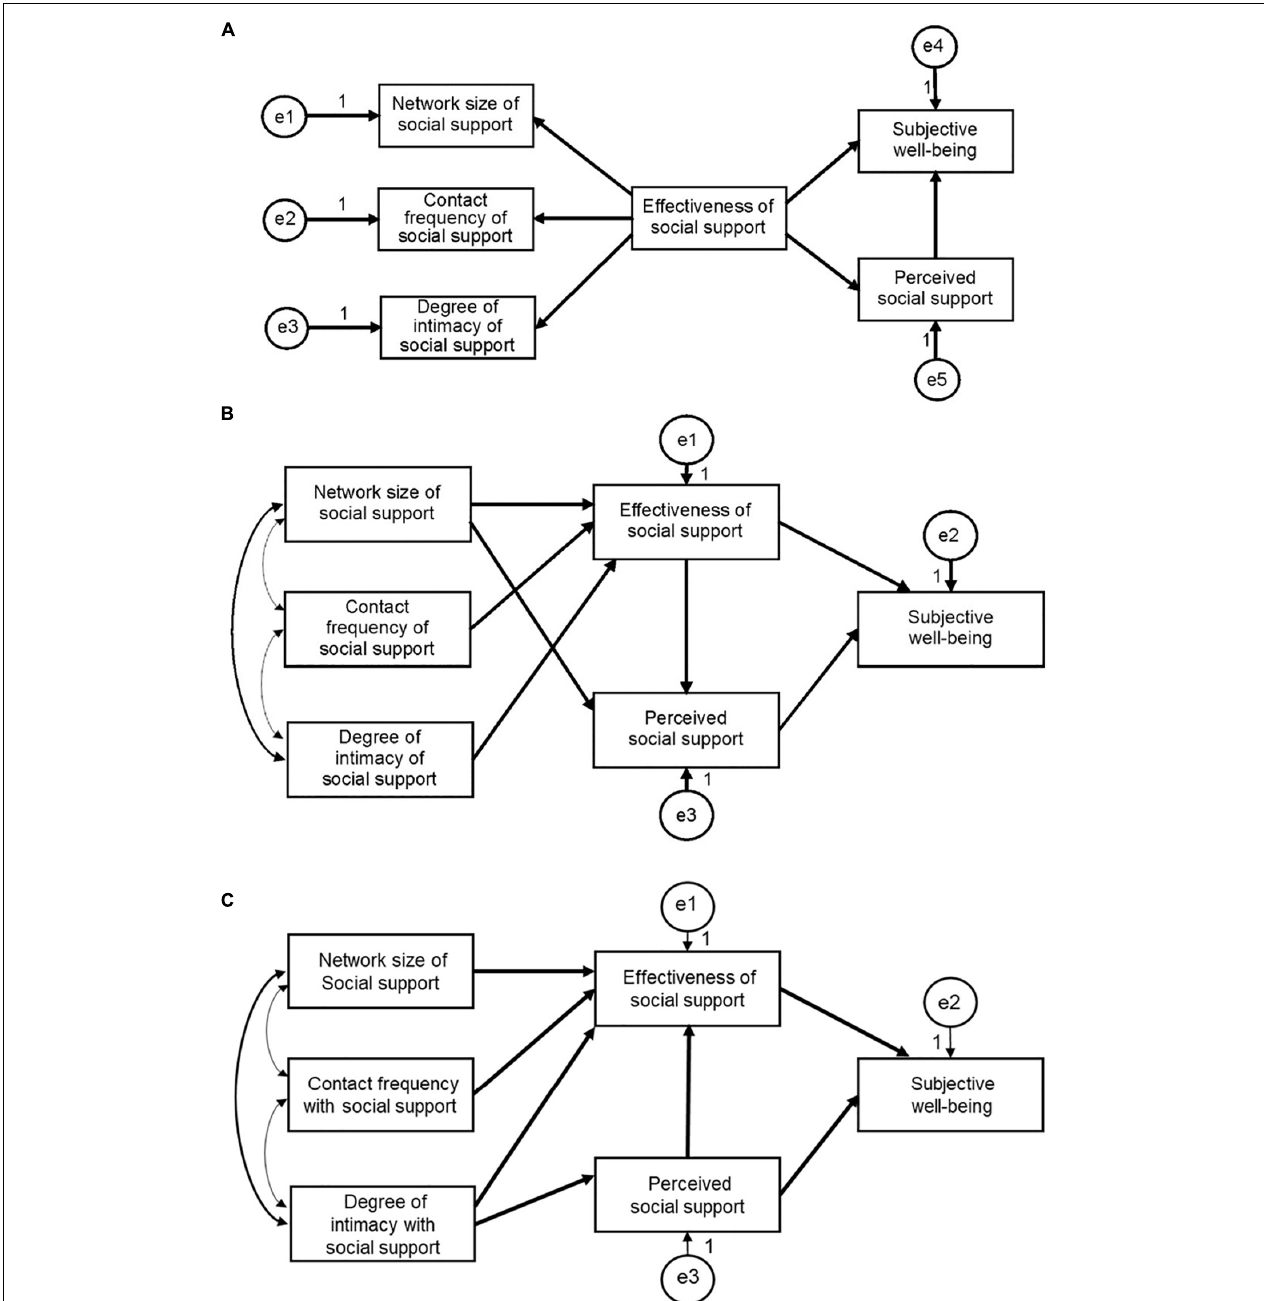
FIGURE 1 | Hypothetical models of the effect of social support network on perceived social support and subjective wellbeing. (A) Hypothetical model 1. (B) Hypothetical model 2. (C) Hypothetical model 3.